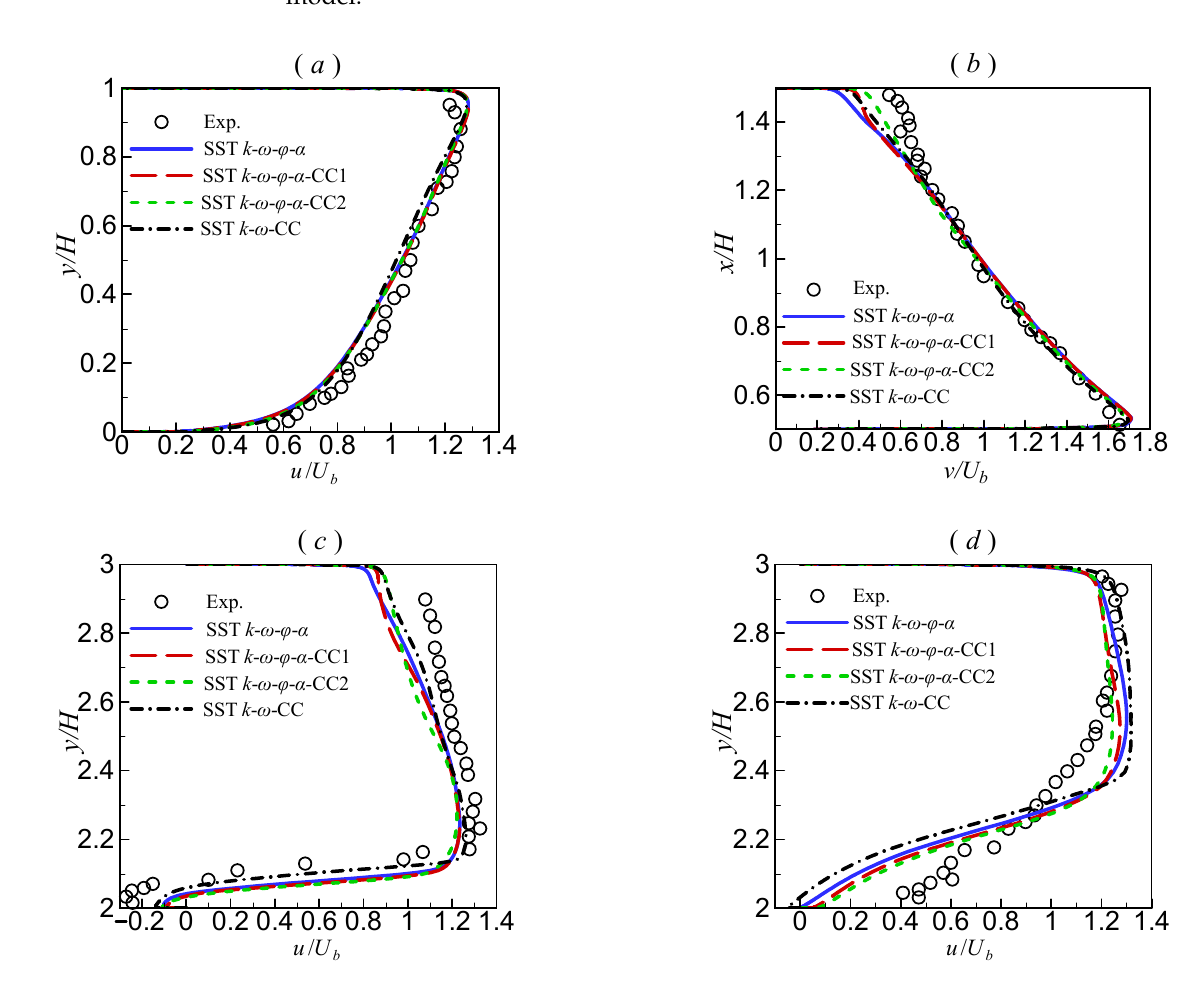
Figure 7. Comparison of velocity profiles along different transverse lines for the 2D U-turn duct flow: ( a ) s / H = 0; ( b ) s / H = π /2; ( c ) s / H = π ; and ( d ) s / H = π +